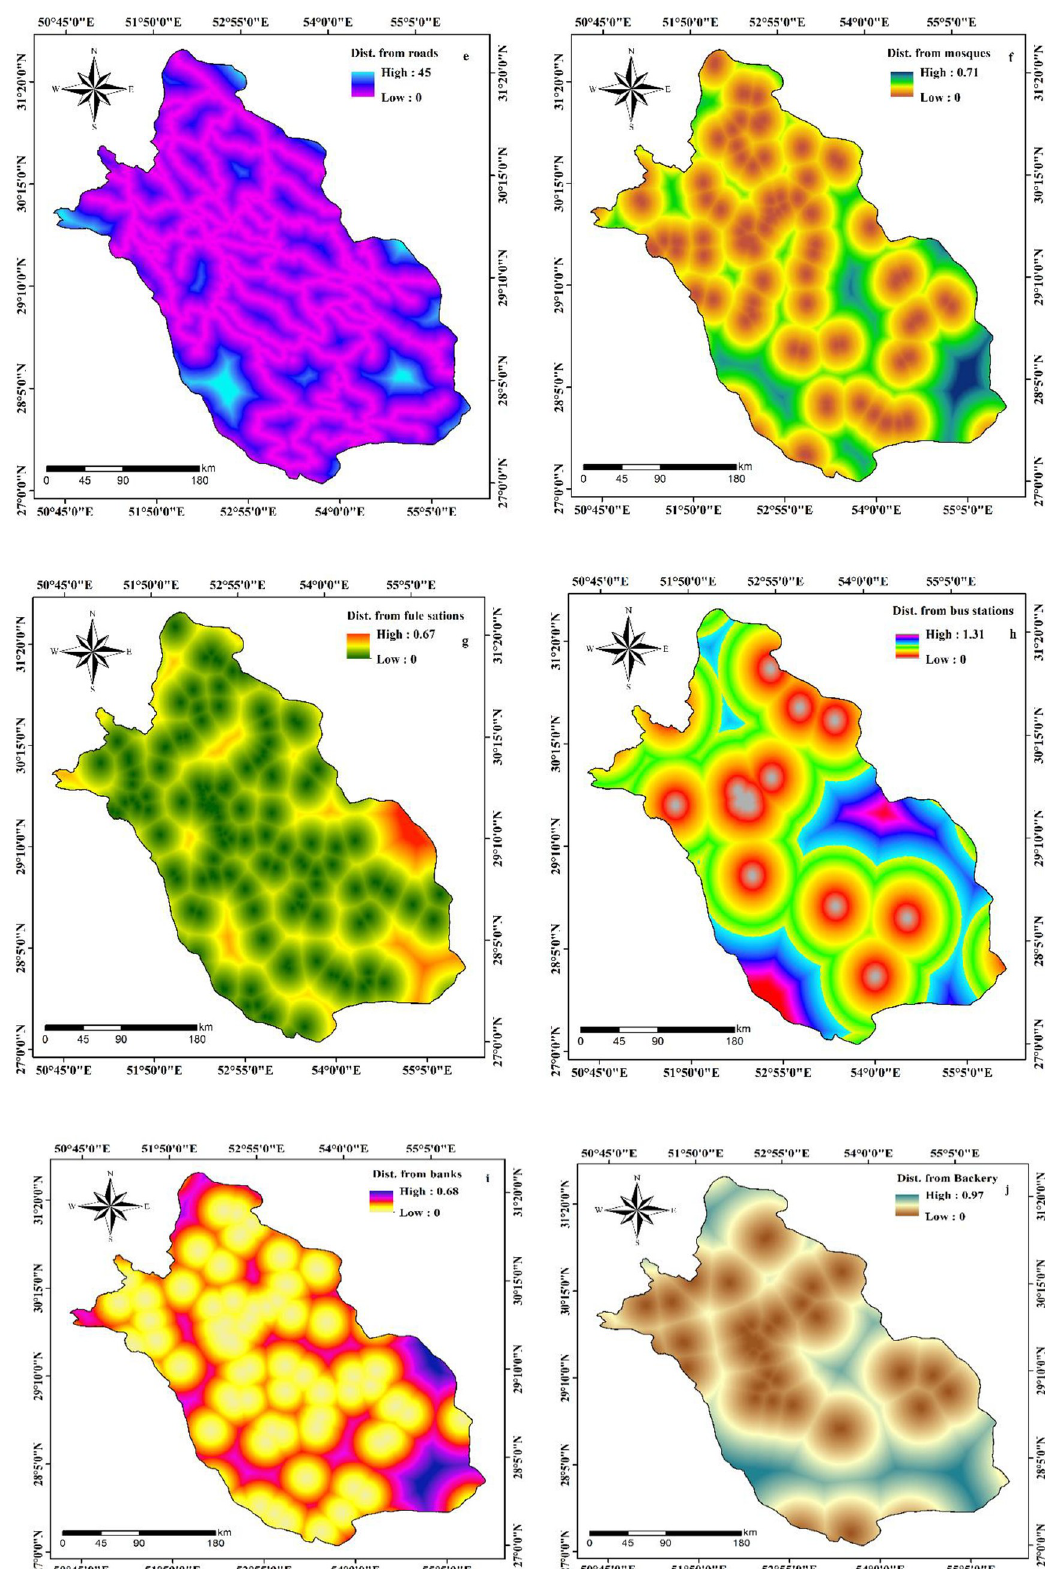
Fig 4. Preparation of effective factors of COVID-19 outbreak. https://doi.org/10.1371/journal.pone.0236238.g004 PLOS ONE | https://doi.org/10.1371/journal.pone.0236238 July 28,